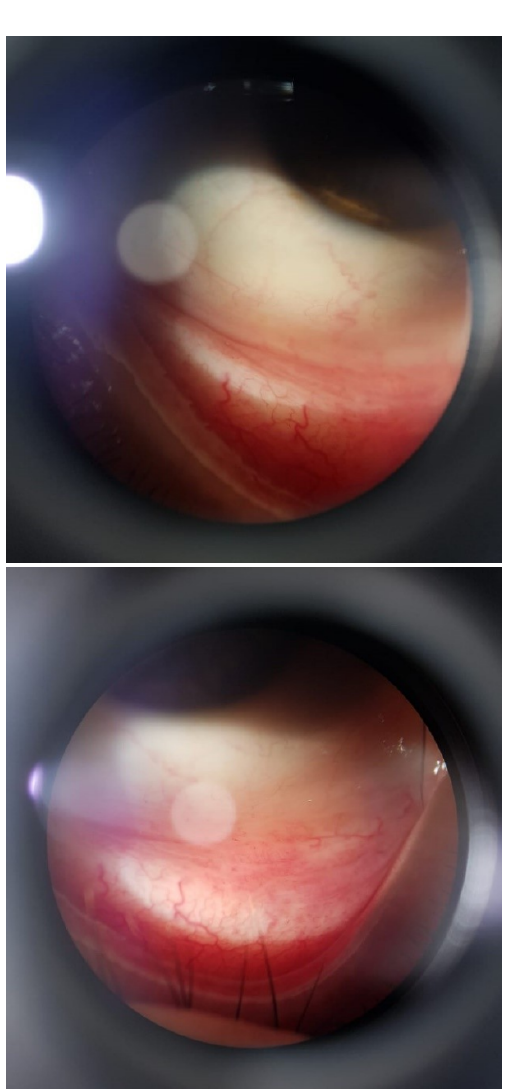
Figure 2: Biomicroscopy showing total lesions on clinical